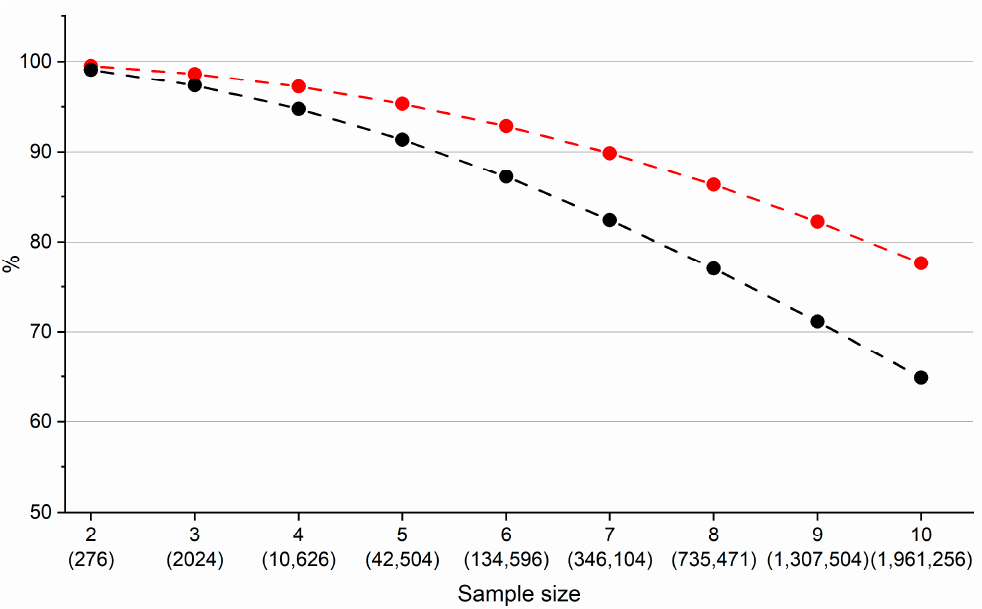
Figure 6. Portion (%) of all combinations of compounds containing two to ten components for which RtModel EXP and RtModel QSRR predicted baseline separation (Resolution Coefficient (RC) = 1). The total number of combinations evaluated is in parentheses. Black line corresponds to model built from predicted data and red line corresponds to model built from mixture of predicted and experimental data. See text for details.